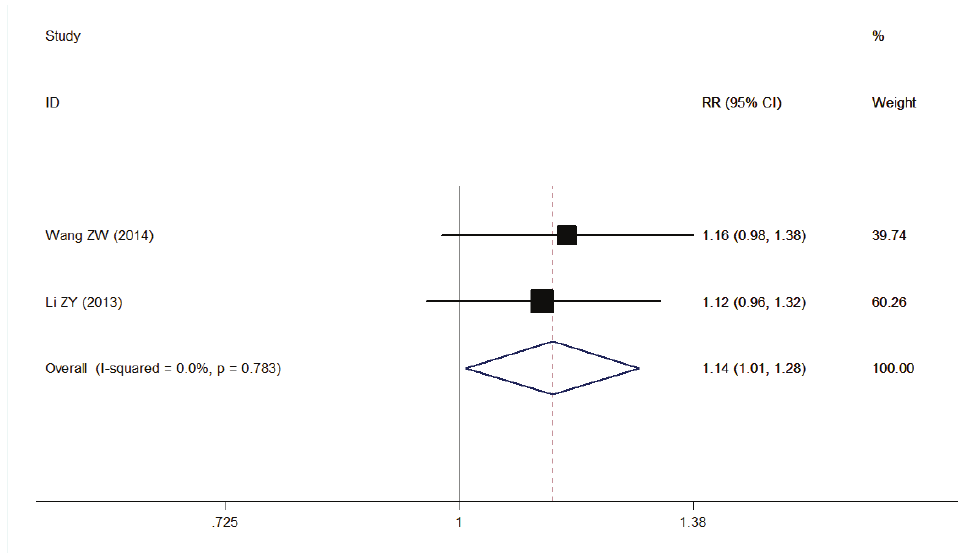
Figure 5: Forrest plot evaluation 2-year survival rate of S-1 combined with radiotherapy versus radiotherapy alone